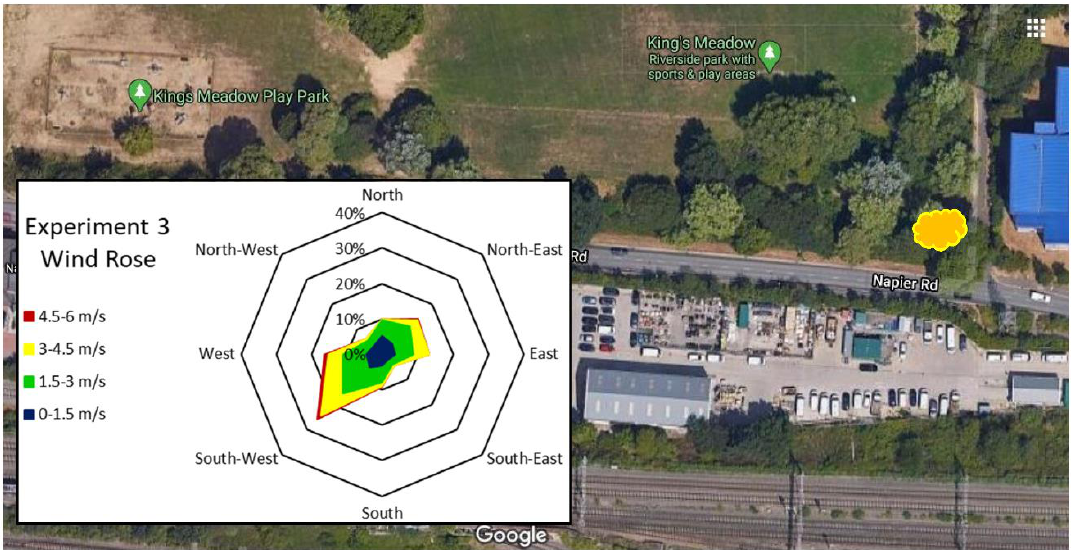
Figure 4. Location of the minor-road sampling site for Experiment 3, and corresponding wind rose indicating prevailing wind conditions a month prior to sampling. This site corresponds to orange location marker 3 in Figure 1.